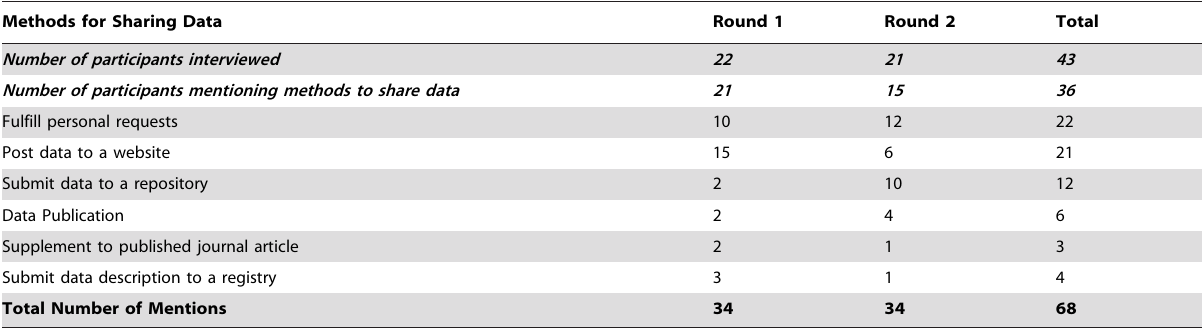
Table 3. Methods for sharing